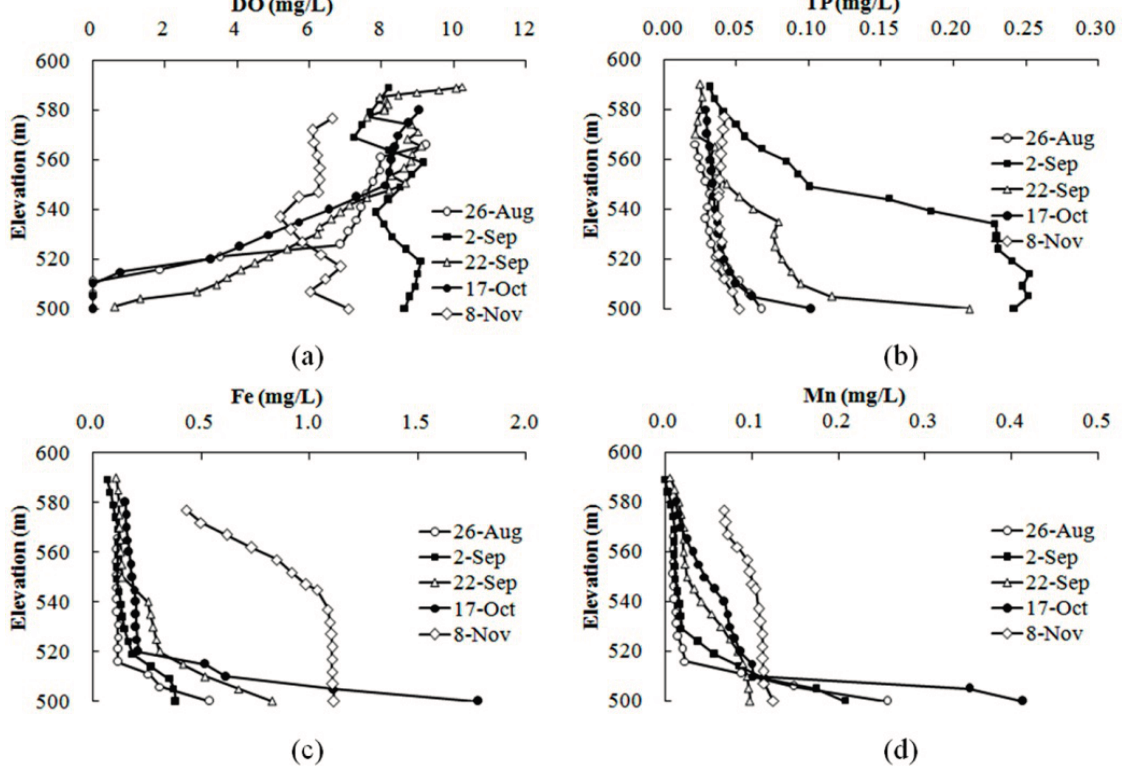
Figure 7. Vertical variation in DO ( a ), TP ( b ), Fe ( c ) and Mn ( d ) in the Heihe Reservoir at S1 in